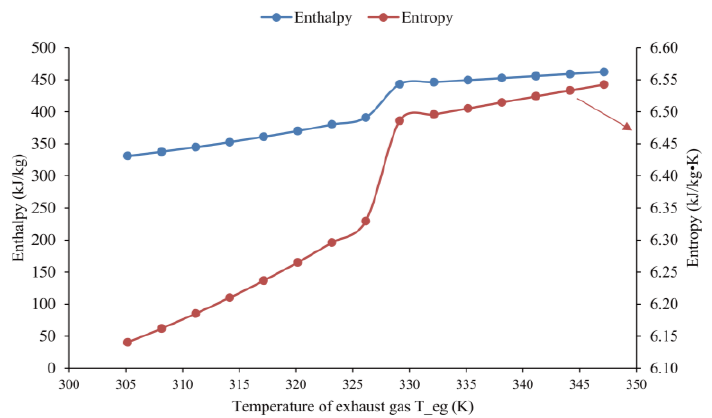
Figure 7. Effect of the outlet temperature of the exhaust gas on the enthalpy and entropy.